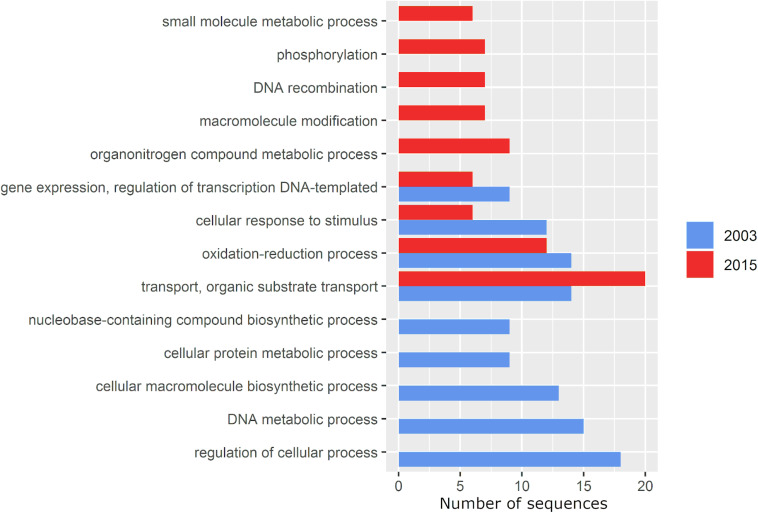
Multi-level gene ontology graph of the exclusive accessory genome of P. otitidis under the Biological Process category calculated by Blast2GO. The gene ontology terms (functions) are on the Y axis and the X axis represents the number of gene sequences assigned to each one. The 2003 and 2015 samplings are marked in blue and red, respectively. Bars alone represent functions lost (2003, blue) and gained (2015, red). Specific functions and annotation details are in Supplementary Tables 3, 4.